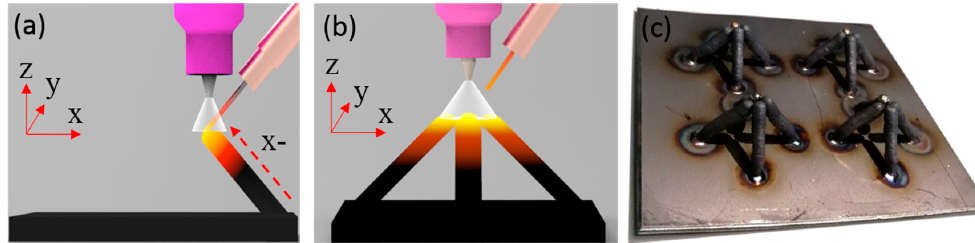
Figure 3. ( a ) The schematic diagram of manufacturing process of x − ; ( b ) the schematic diagram of one cell; ( c ) the sample manufactured by WAAM.